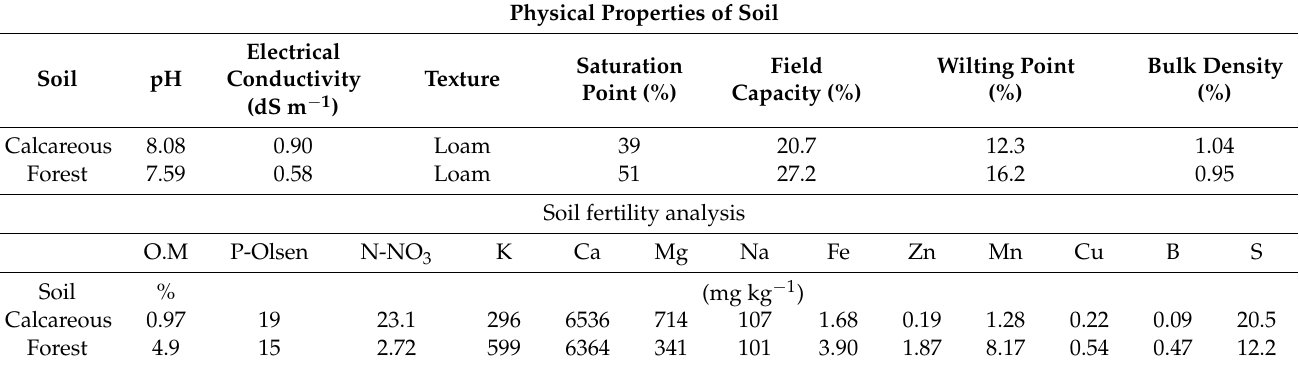
Table 1. Physical-chemical analysis of the soil.